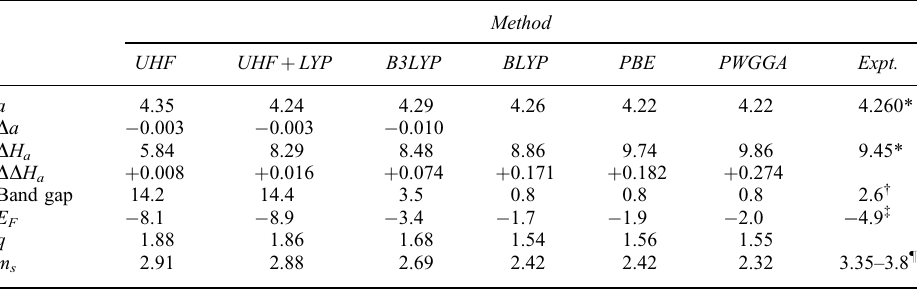
TABLE XII (c) Calculated Bulk Properties for AF 2 Antiferromagnetic CoO: Lattice Constant a , Difference D a to Ferromagnetic State (A˚ ), Heat of Atomization per CoO Unit D H a , Difference to Ferromagnetic State DD H a , Band Gap, Fermi Level E F (eV), Mulliken Charges q (a.u.), and Atomic Spin Moment m s ( m B ).